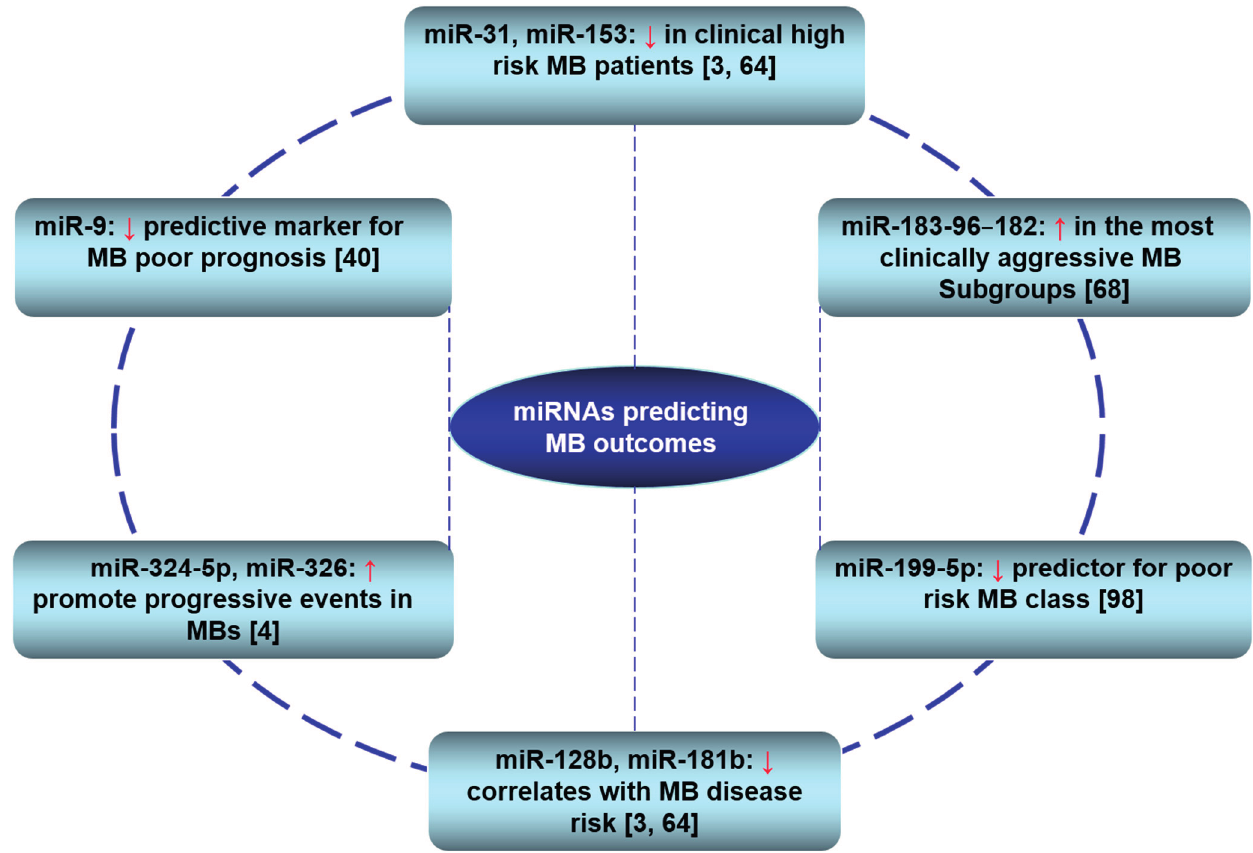
Figure 2. miRNAs associated with outcome prediction in MB patients. ↑ : up-regulated; ↓ :